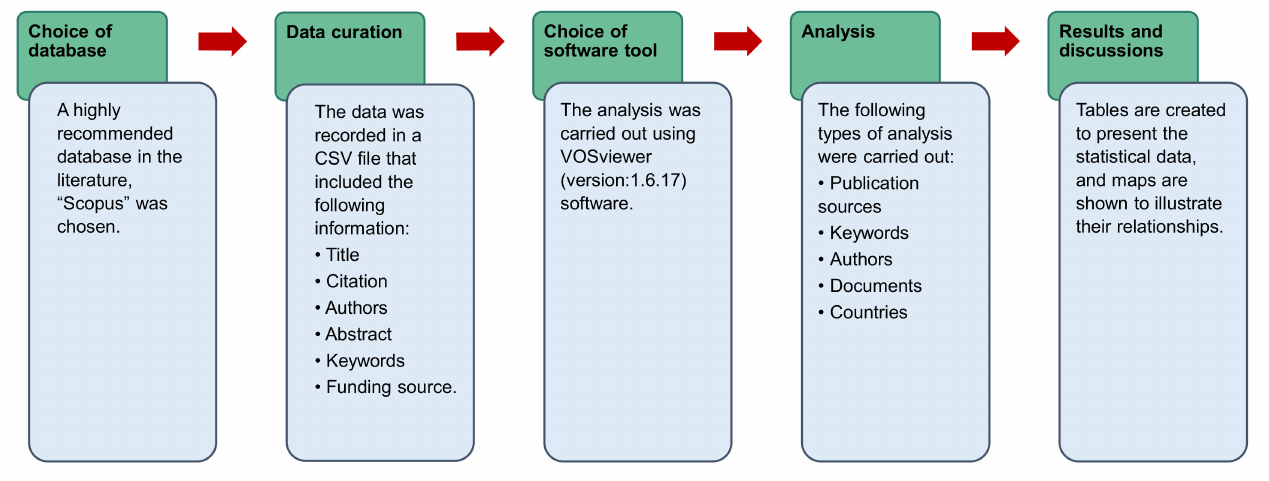
Figure 2. Sequence of the research